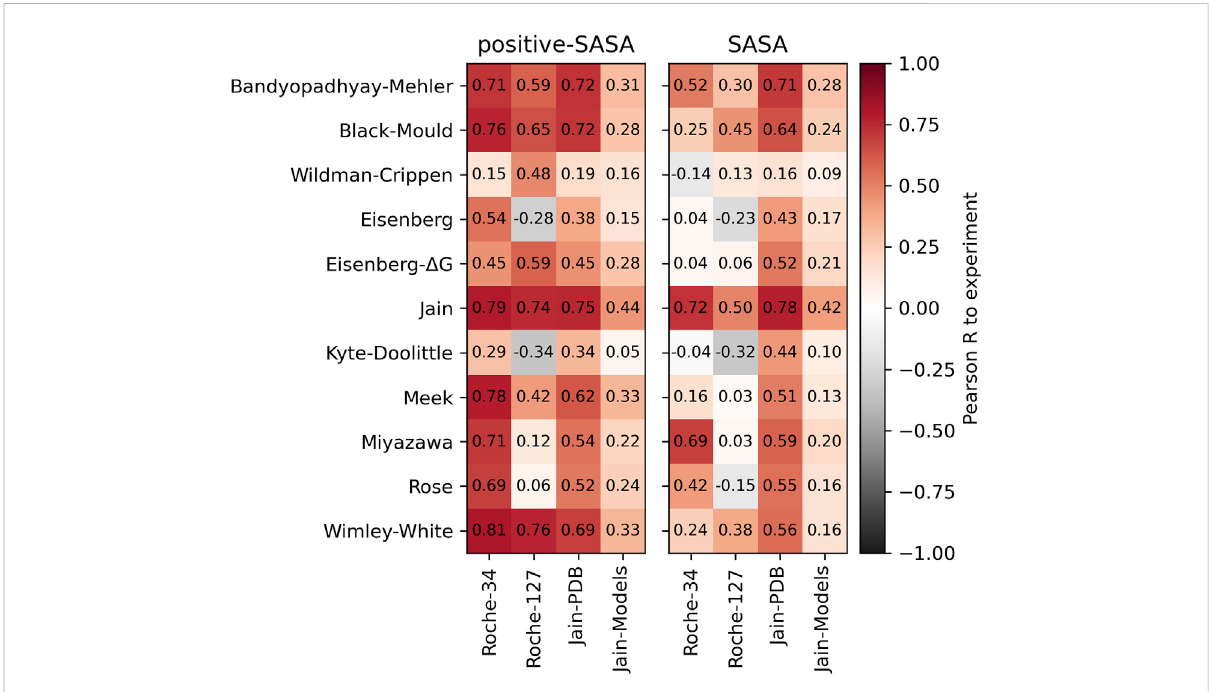
FIGURE 2 Pearsoncorrelationvaluesobtained byapplyingthepositivesurfacescore(left)andthedirectsurfacescore(right)onthedifferentdatasetsand comparing to the experimental HIC